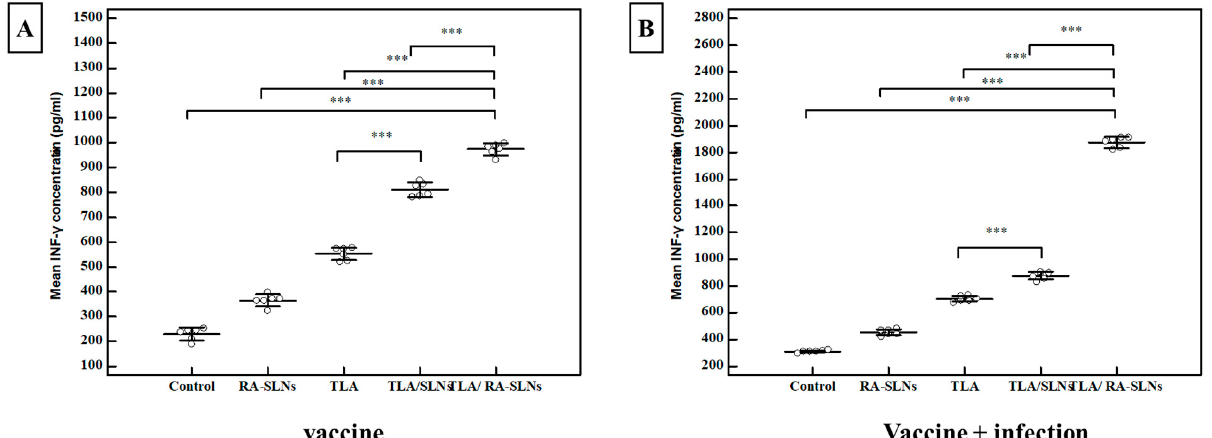
Figure 8. The IFN- γ concentrations among various assessed protocols. ( A ) INF- γ concentration (pg/mL) two weeks after the final immunization dose (vaccine). ( B ) IFN- γ concentration (pg/mL) at the 4th week after infection (vaccine + infection). Data were expressed by using mean ± SD. ***: statistically significant at p ≤ 0.001.